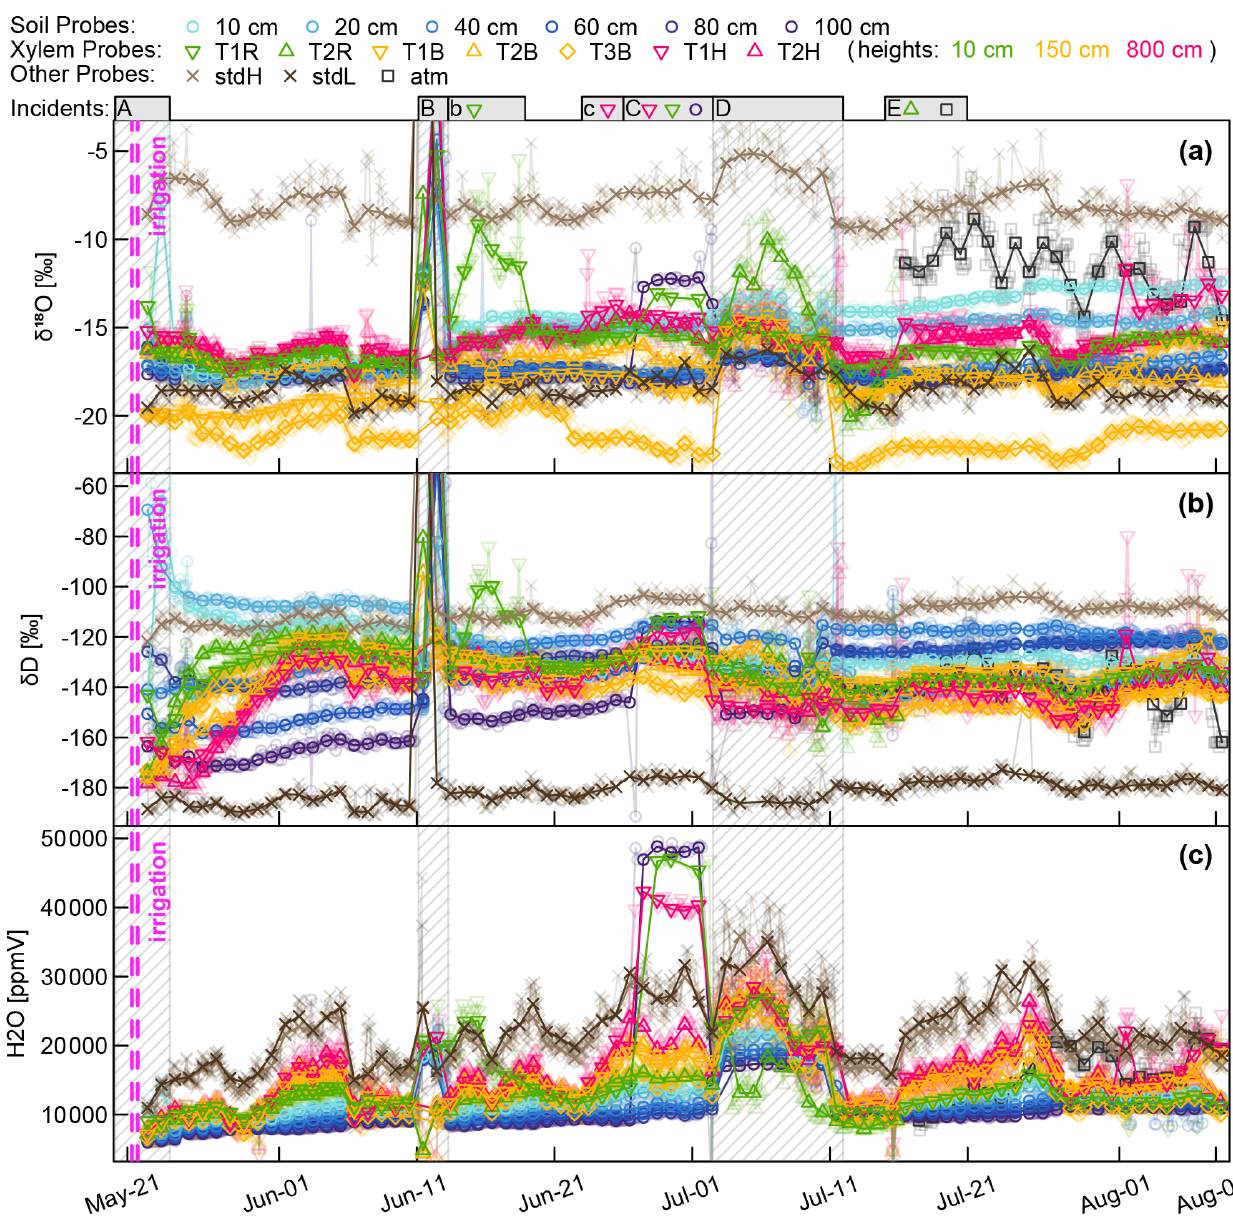
Figure A1. Aggregated CRDS raw data (stable water isotopes and moisture) of all WIP measurements. Solid points indicate median values of daily measurements, while actual values are indicated translucently. Above the plots several incidents are indicated and numbered with letters. In case no symbols are associated with the incident, all probes are affected otherwise just the ones indicated. (A) Initial phase with some unreliable data. (B) Intrusion of water (through probe T1R) into the system during a high-intensity rainfall event. (b) Aftermath of (B); probe T1R still contains liquid water. (c) (C) Effects of strong winds and frail setup lead to loosened electric connections, deactivating the valves of three probes. (D) Interruption of dry air supply, no dilution and no through-flow. (E) Tubing of probe T2R was severed by rodents; from then on the system measured the atmospheric air on this valve